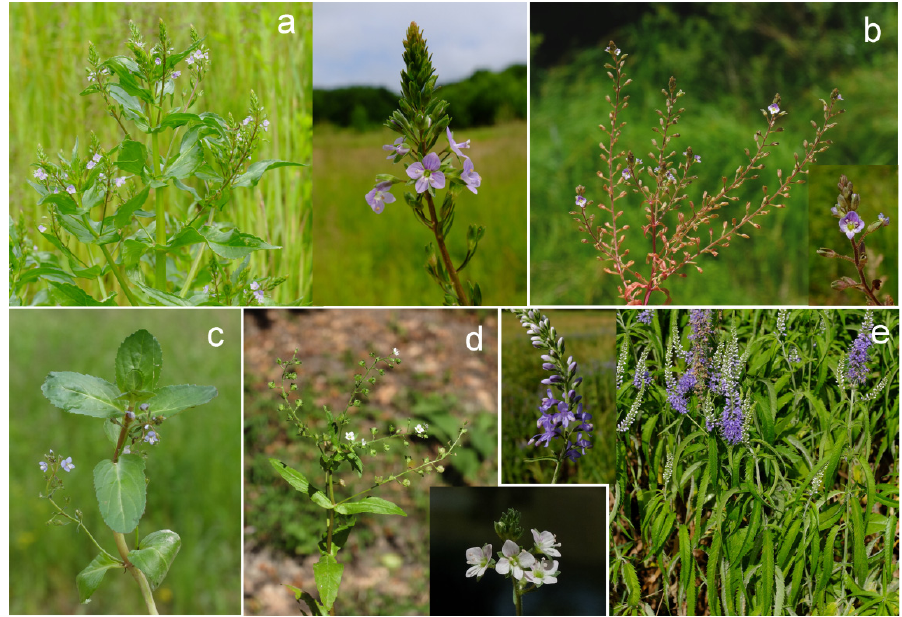
Figure 3. Photographs of Veronica taxa collected from wet habitats: V . anagallis-aquatica ssp. anagallis-aquatica ( a ), V. anagalloides ( b ), V. beccabunga ( c ), V . catenata ( d ), and V. longifolia ( e ).